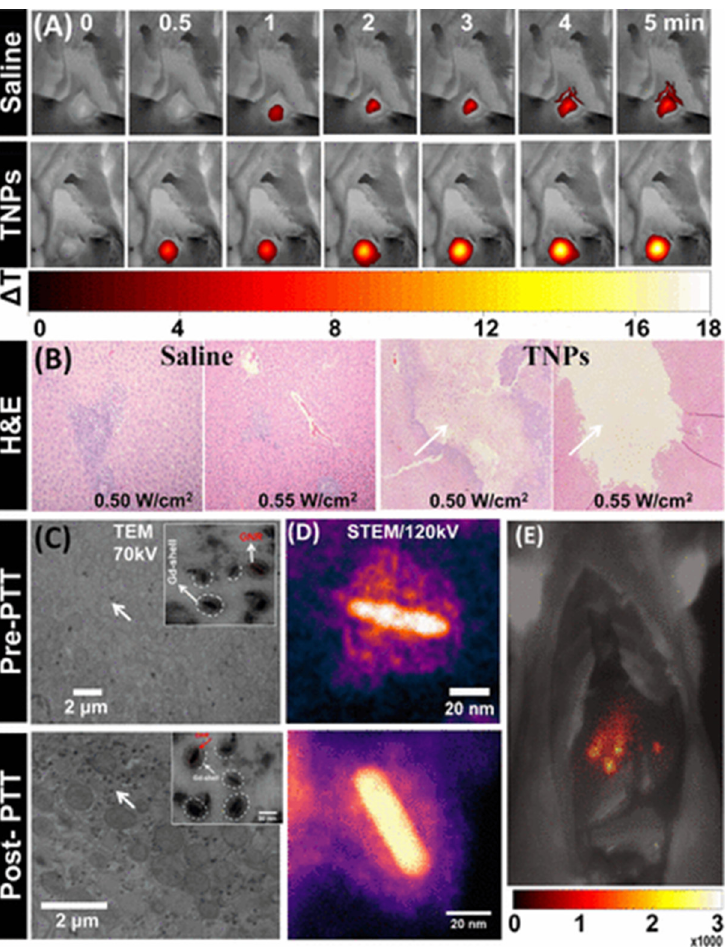
Figure 2. In vivo photothermal therapy of rats. ( A ) Thermal images of CRLM tumor-containing rats. ( B ) Typical histological images of saline and TNP-ablated tumor tissue stained with H&E. Pre-PTT and post-PTT tissue images recorded using ( C ) TEM at 70 kV and ( D ) STEM at 120 kV. ( E ) Emission monitoring after injecting 50 µ L of TNP solution (excitation: ~980 nm, emission: ~1550 nm). Reprinted with permission from [57]. Copyright 2018, American Chemical Society.